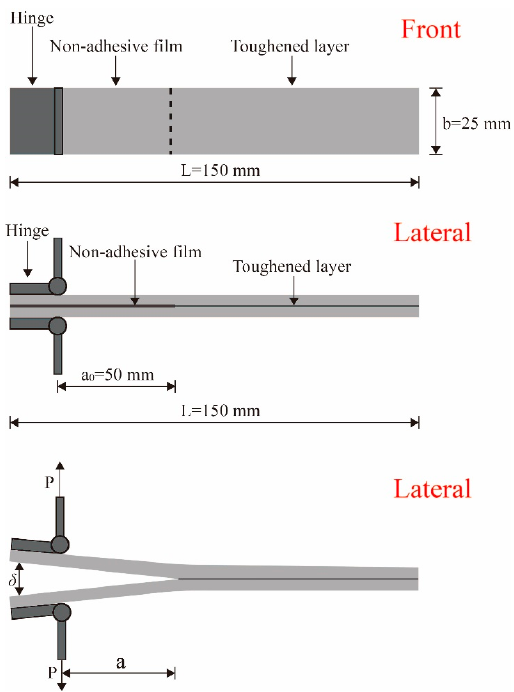
Figure 11. Dimensions and schematics of laminated composite and double cantilever beam (DCB) testing (dimensions are in mm).